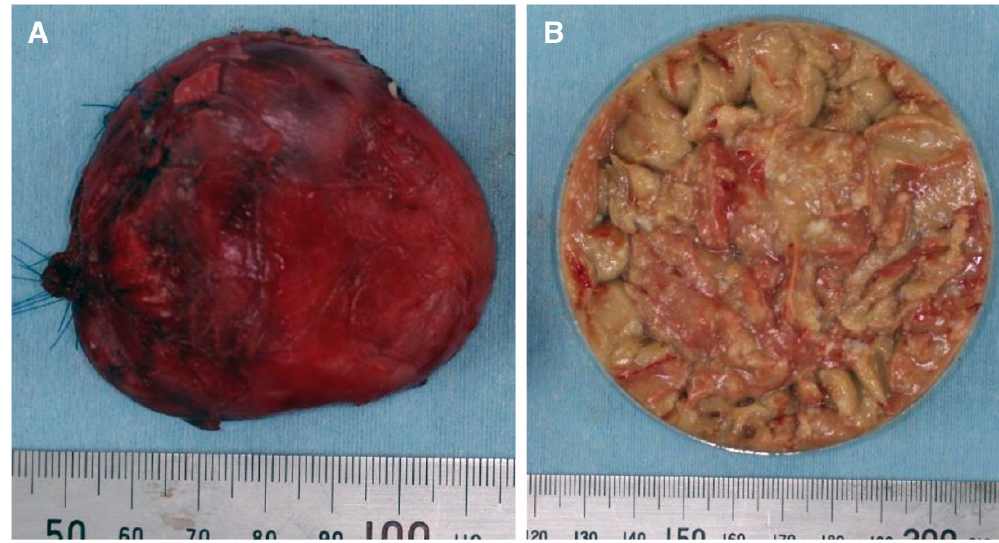
Figure 5. ( A ) Removed cyst, weight 105 g. ( B ) Milky-white mud-like contents of cyst.